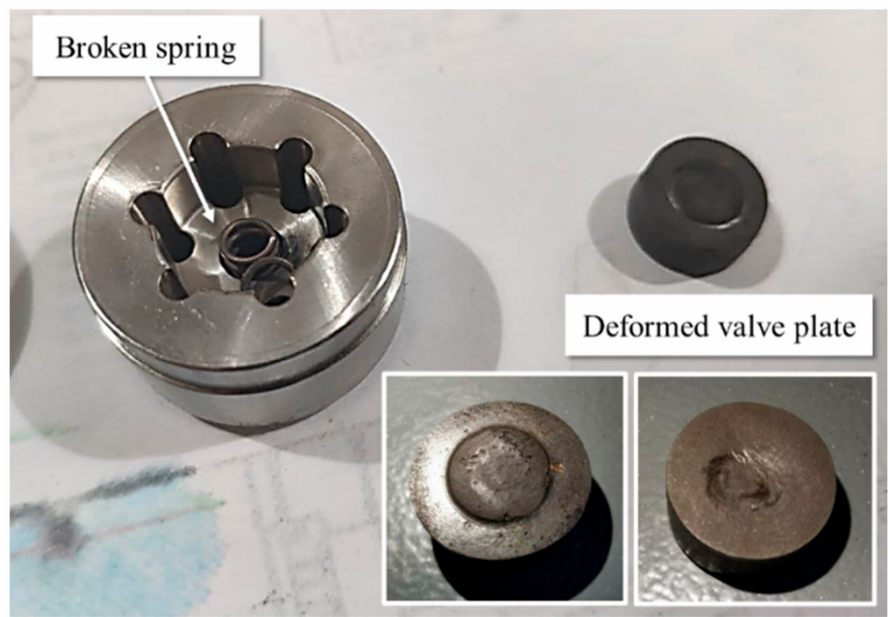
Figure 22. Severely deformed